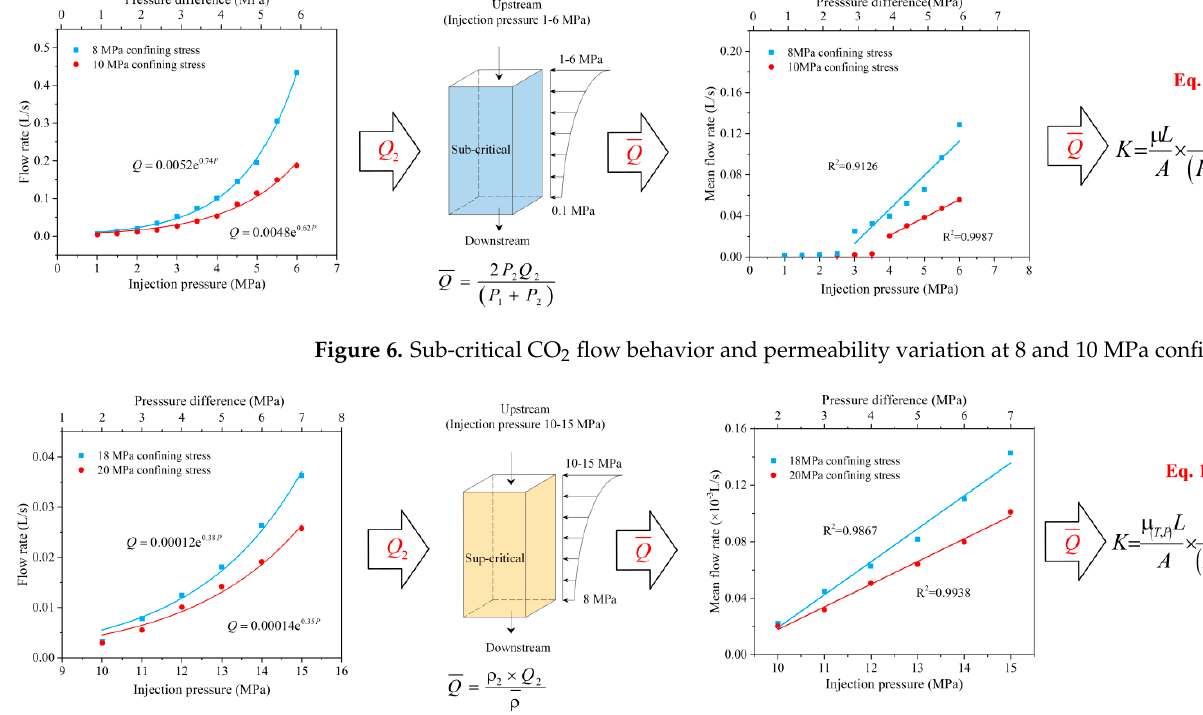
Figure 7. Super-critical CO 2 flow behavior and permeability variation at 18 and 20 MPa confining pressures.